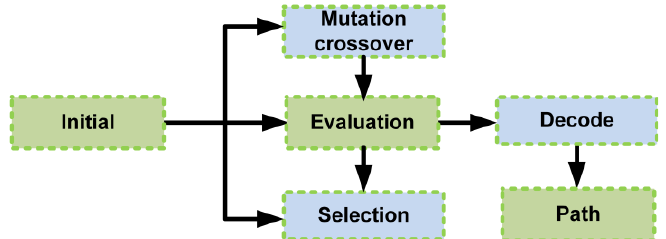
Figure 3. Process of evolutionary algorithms in UAV path planning.